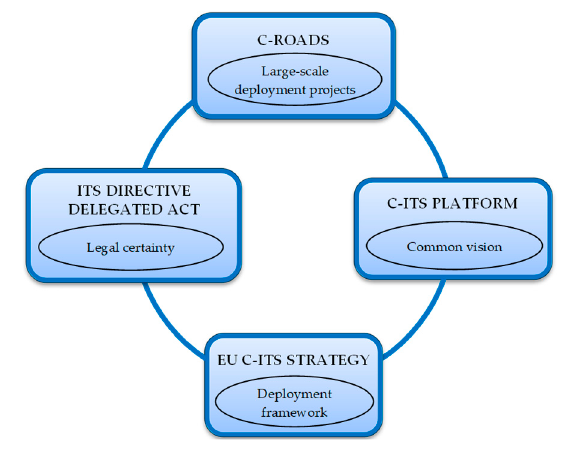
Figure 1. EU Cooperative-Intelligent Transportation Systems (C-ITS) framework.